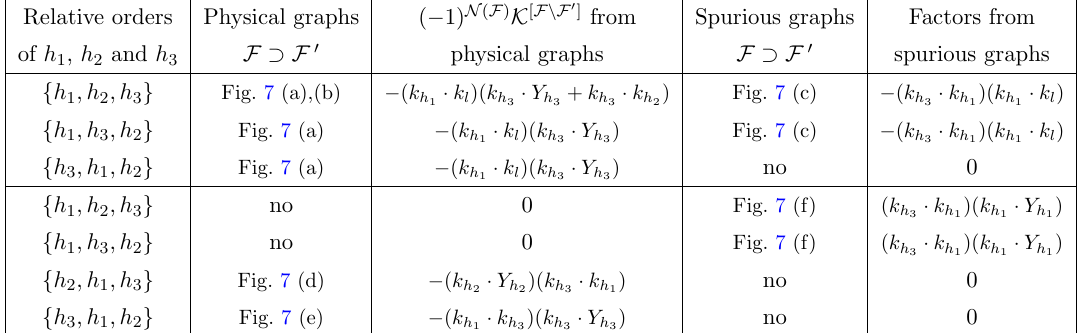
Table 1 . For a given l and a given (cid:12)(cid:12)(cid:12) satisfying eq. (4.1) in the upper part of (cid:12)gure 7, possible relative orders of elements h 1 , h 2 and h 3 are f h 1 ; h 2 ; h 3 g , f h 1 ; h 3 ; h 2 g and f h 3 ; h 1 ; h 2 g . The corresponding (physical and spurious) graphs and factors are collected on the second, third and fourth rows (Recalling that the de(cid:12)nition of Y h ( (cid:27)(cid:27)(cid:27) ) is Y h ( (cid:27)(cid:27)(cid:27) ) = P k i ). Relative orders for graphs in (cid:27) (cid:0) 1 ( i ) <(cid:27) (cid:0) 1 ( h ) the lower part of (cid:12)gure 7 and their factors are collected on the last four rows.